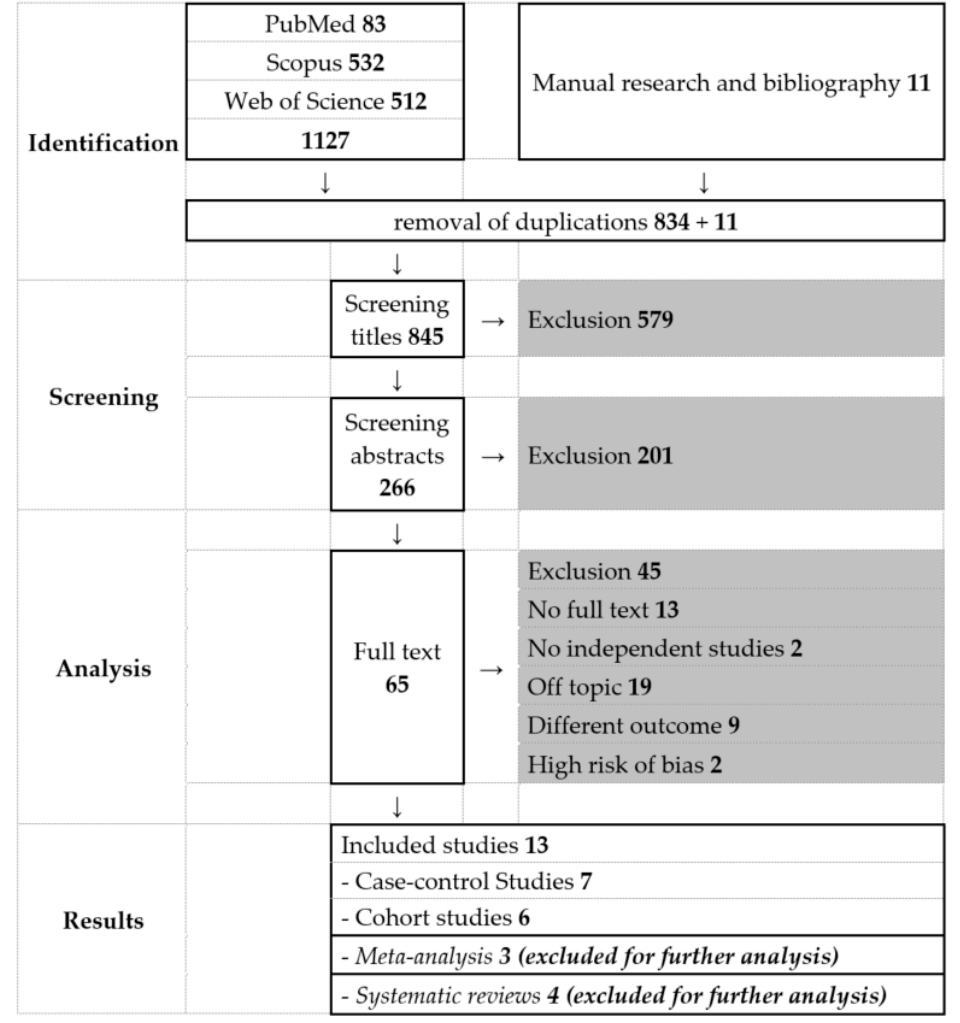
Figure 2. PRISMA